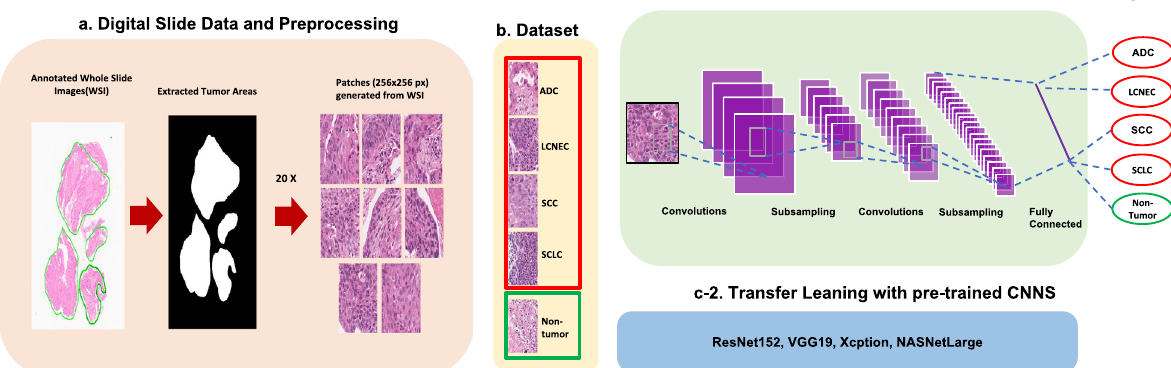
Figure 1. Workflow of AI model for multinomial pattern classification in lung cancer biopsies. ( a ) Digital slide data and preprocessing. Cancer regions on the whole slide images (WSIs) were annotated by pathologists, then the tumor areas were extracted and used to generate non-overlapping patches 256 × 256 pixels in size at a magnification of 20 × . ( b ) Dataset. The dataset contains a total of 5 classes with 21 of ADC, 14 of LCNEC, 22 of SCC, and 21 of SCLC WSIs, as well as 127 of non-tumor WSIs. 10,049 patches were generated from the original 205 WSIs containing the four lung cancer subtypes and negative cases. ( c-1 ) Convolutional Neural